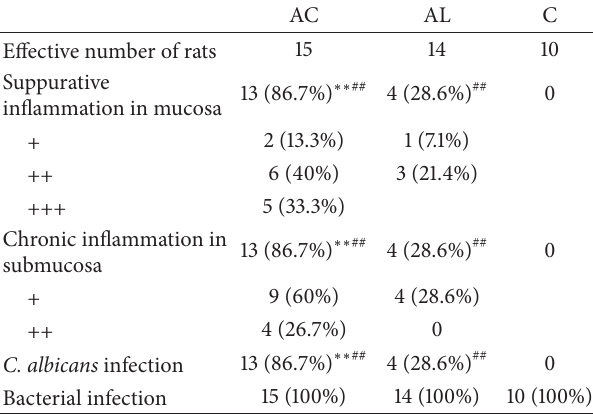
Table 2: Histopathologic findings of inflammatory changes in the